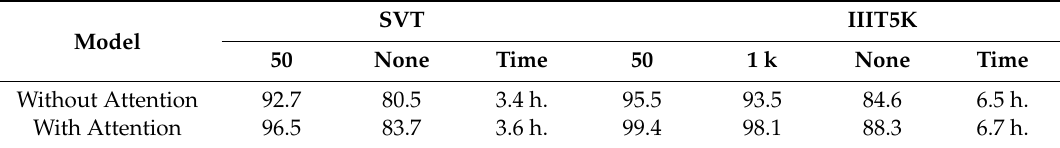
Table 7. Attention mechanism and its recognition accuracies (%).